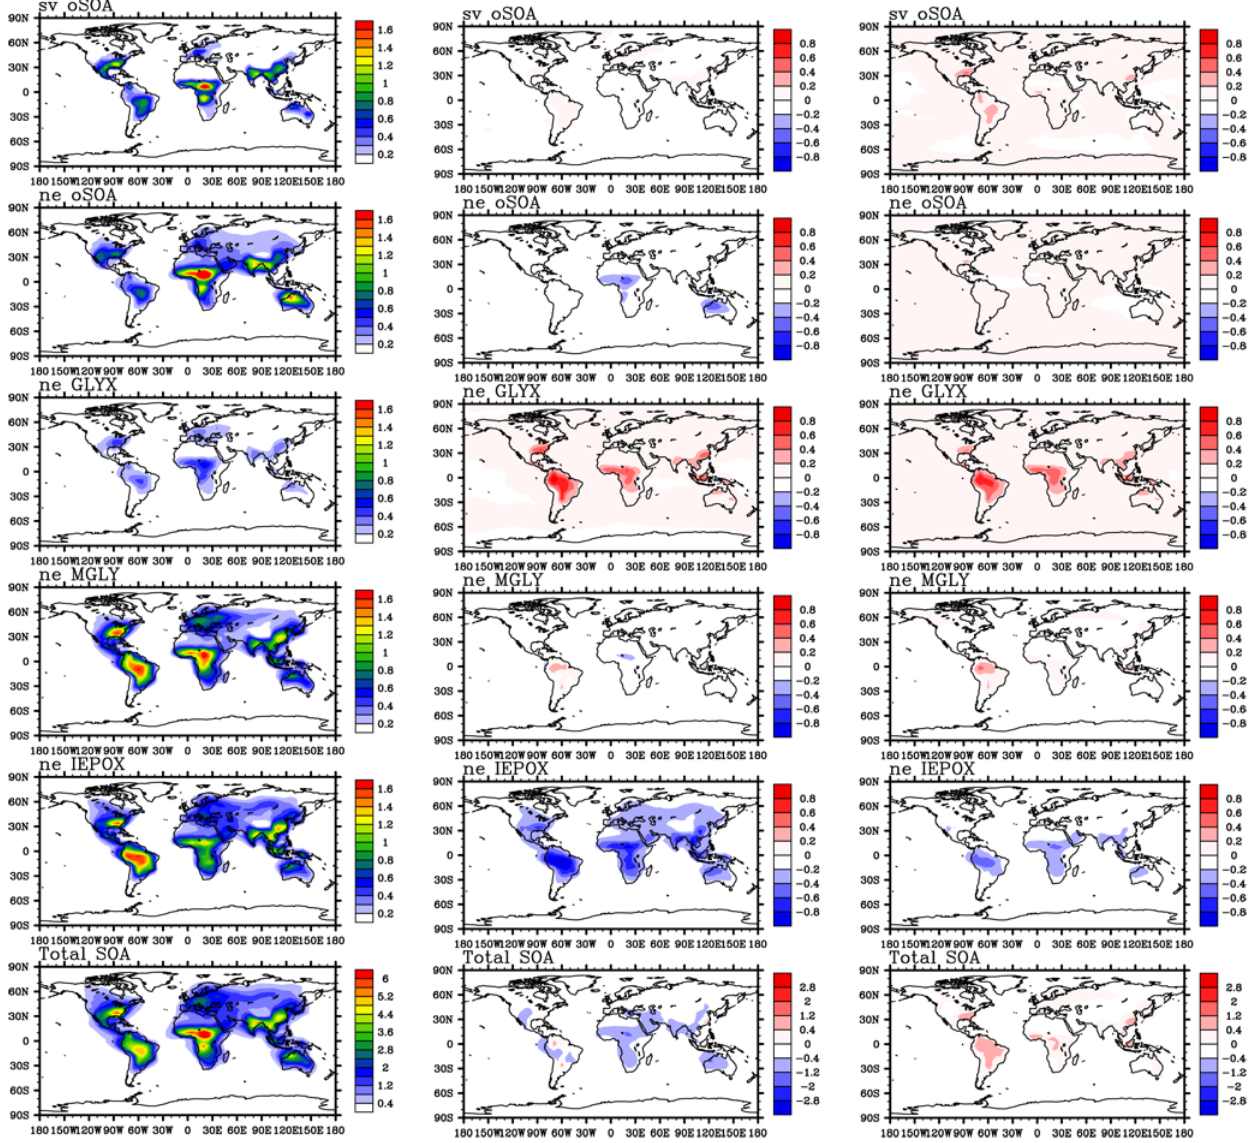
Fig. 2. Annual mean simulated surface SOA concentrations in Simulation A (first column) and the changes in surface SOA concentrations from Simulation A after including the new HO x recycling mechanism (Simulation B-Simulation A) in the second column, and reducing the reaction rates of 1,5-H and 1,6-H shifts by a factor 10 (Simulation C-Simulation A) in the third column for each SOA component (the first 5 rows) and the total SOA (the sixth row). The maximum and minimum values for color scales in the second and third column are set to half the maximum values of those in the first column (Simulation A). Units: µgm − 3